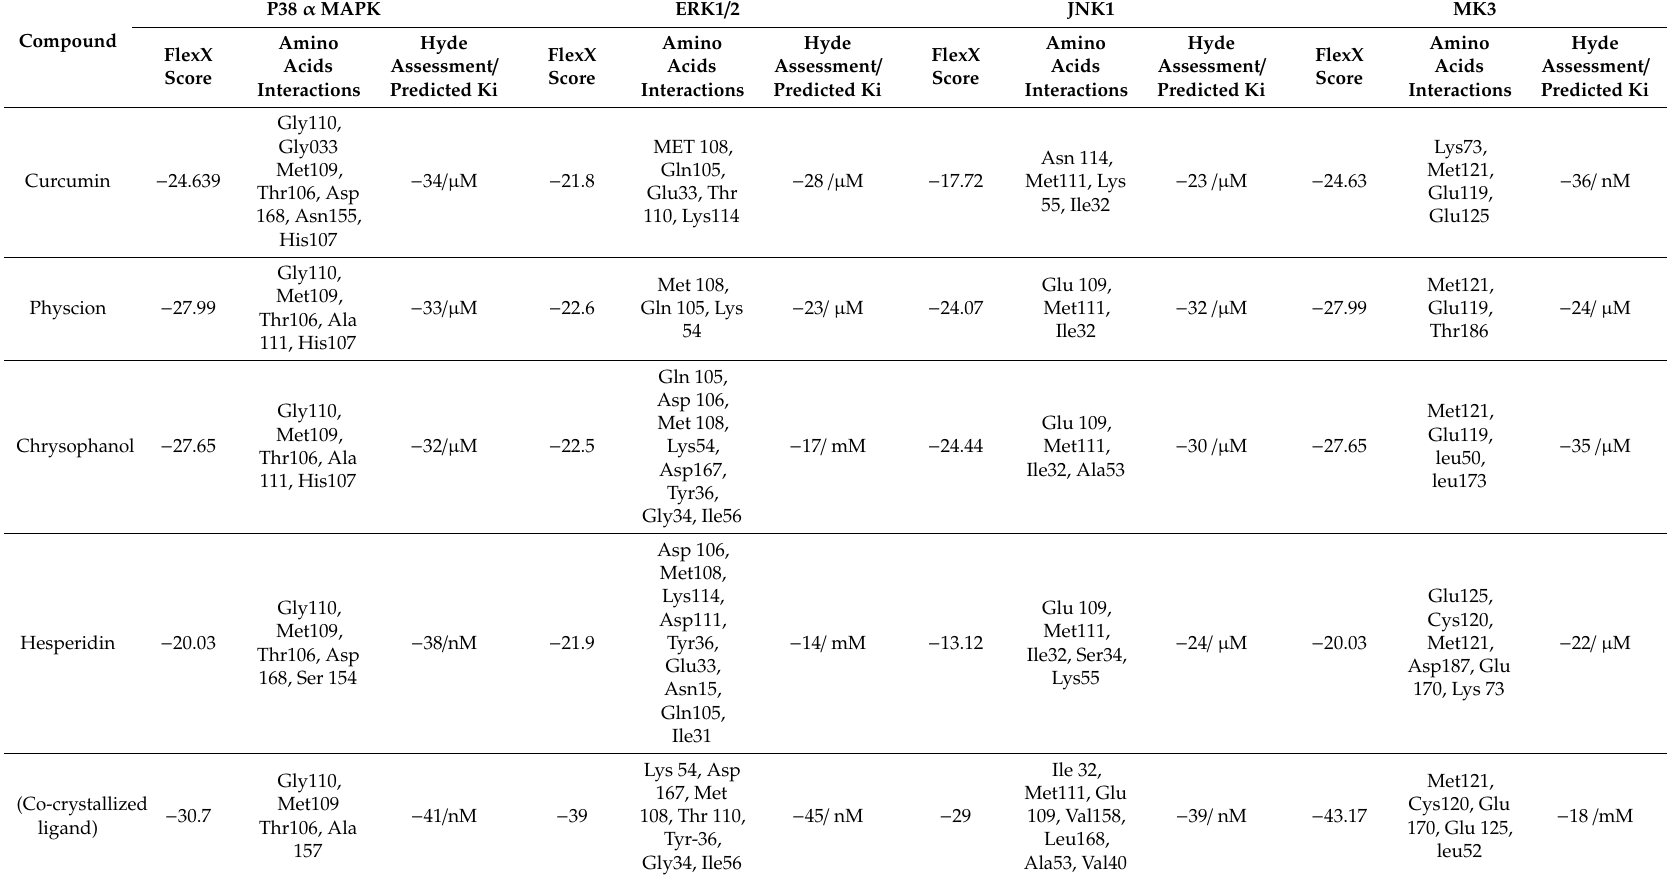
Table 3. The interaction of docking the isolated compounds (1–4) with key amino acid residues in the binding sites of 4 MAPKs (P38 α , ERK2, JNK& MK3), in comparison to the co-crystallized